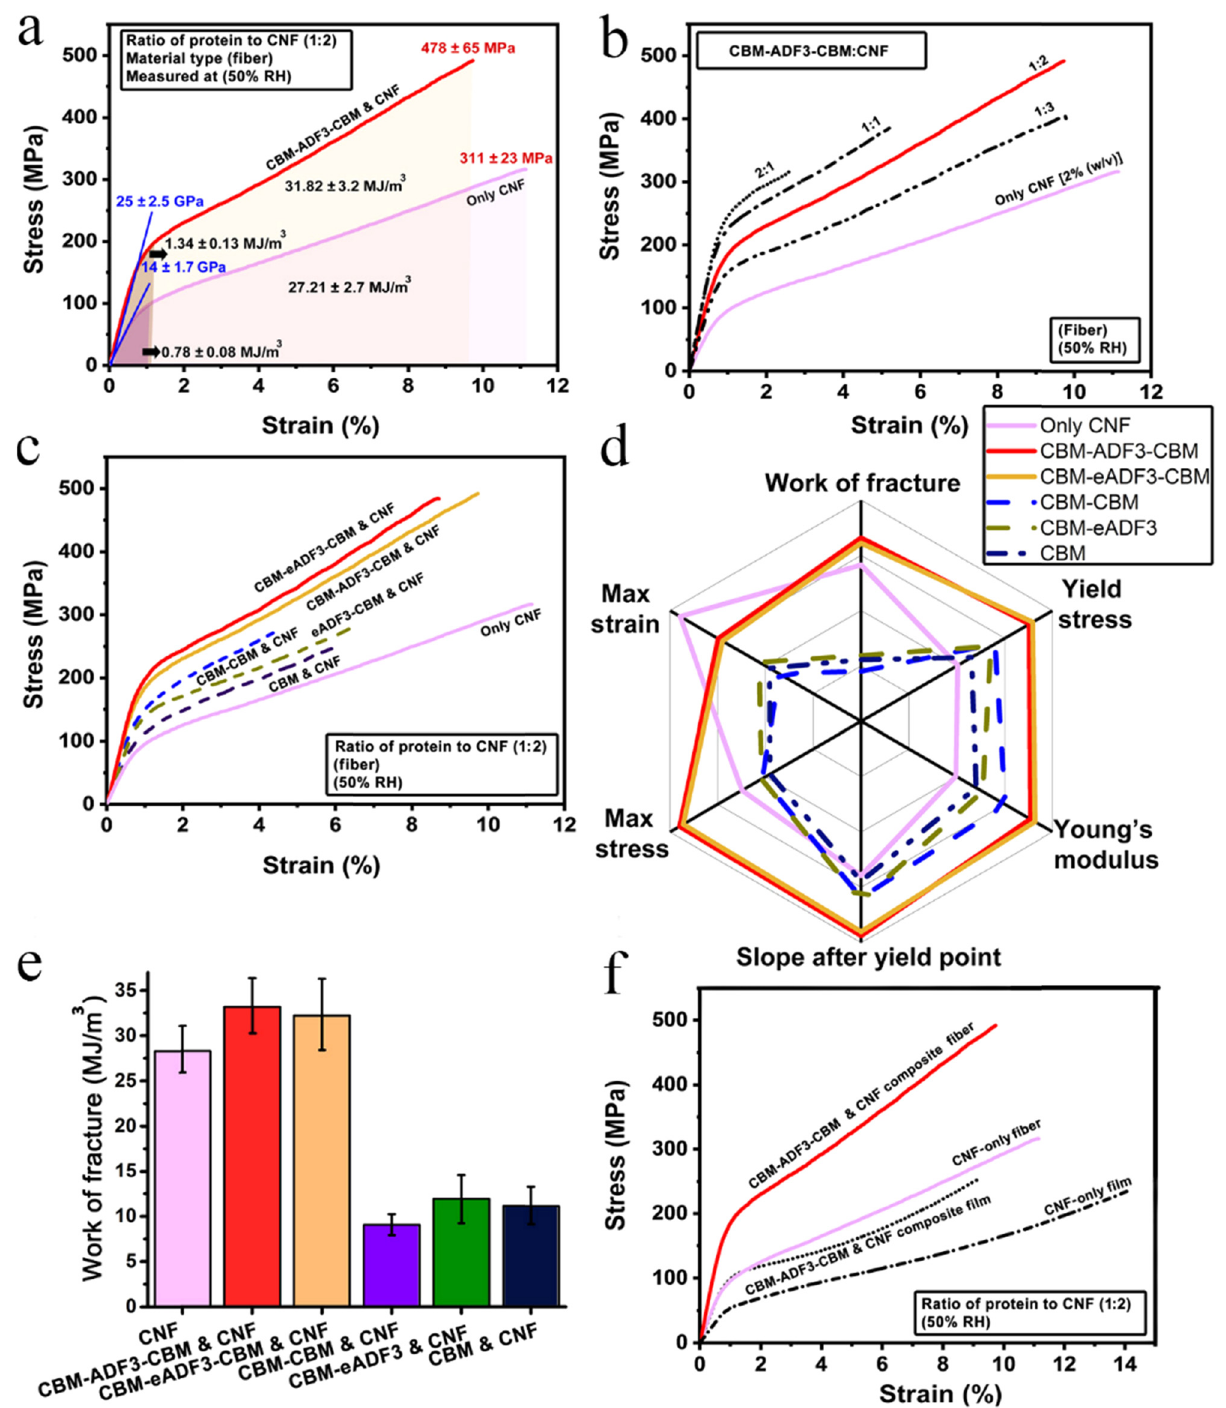
Figure 2: Properties of composites of spidroin proteins and nanocellulose ( 57 ) . ( a ) Stress – strain curves of triblock spidroin composites and CNF fi bers. ( b ) Stress – strain curves of protein and CNF composites with di ff erent protein - to - CNF ratios. ( c ) Stress – strain curves of composite fi bers from di ff erent protein variants. ( d ) Performance comparison of composite fi bers from di ff erent protein variants. ( e ) Toughness values of composite fi bers from di ff erent protein variants. ( f ) Stress – strain curves of the oriented ( fi ber ) and non - oriented composites and CNF. Copyright 2019, American Association for the Advancement of Science ( AAAS )